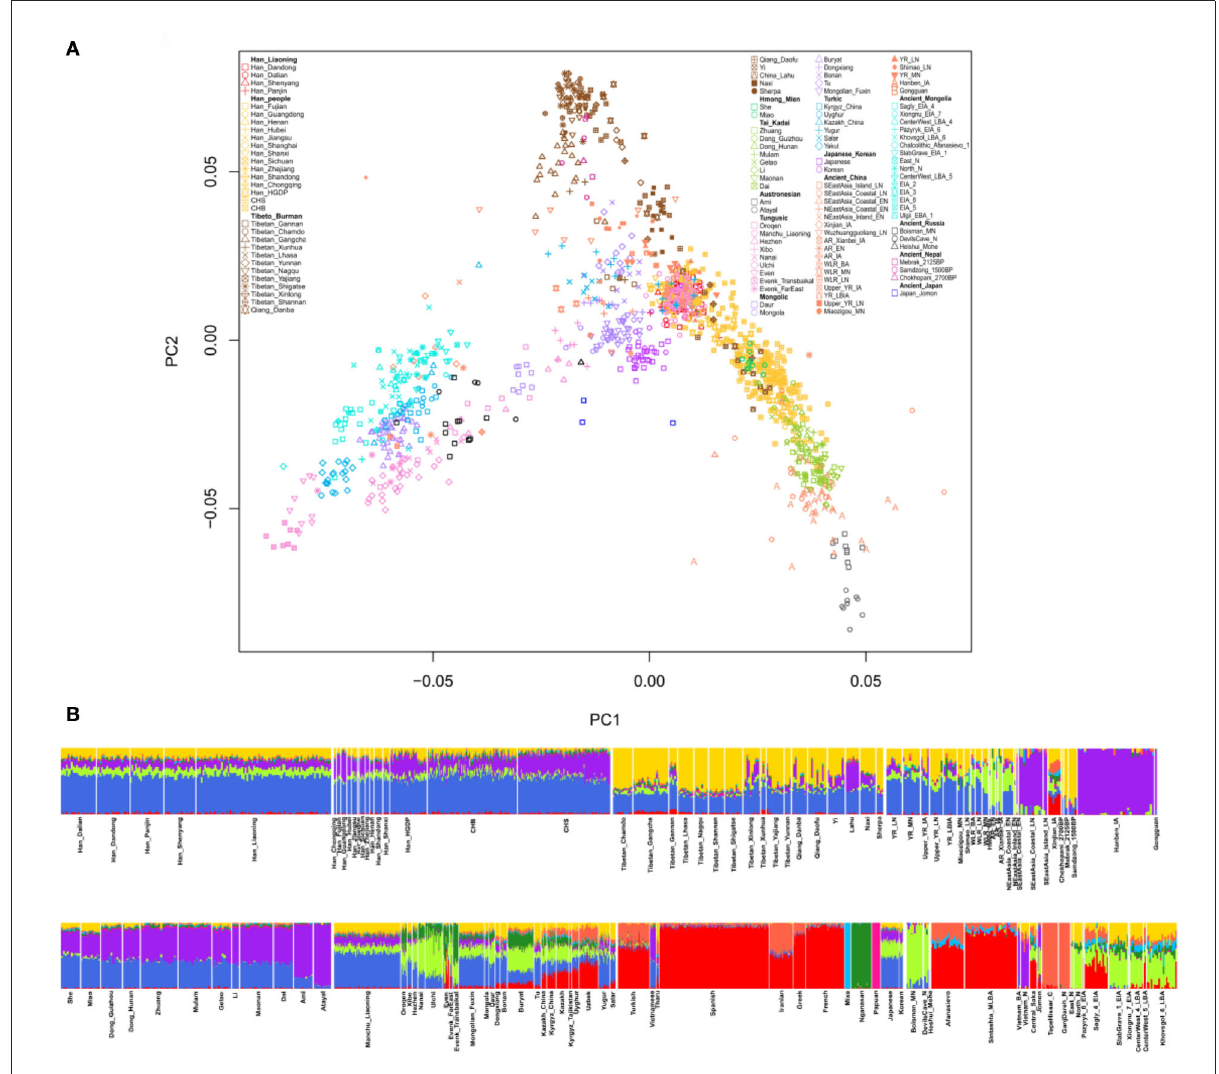
FIGURE2 Population structure of ancient and modern Eurasian populations. (A) Principal component analysis; (B) ADMIXTURE-based model cluster